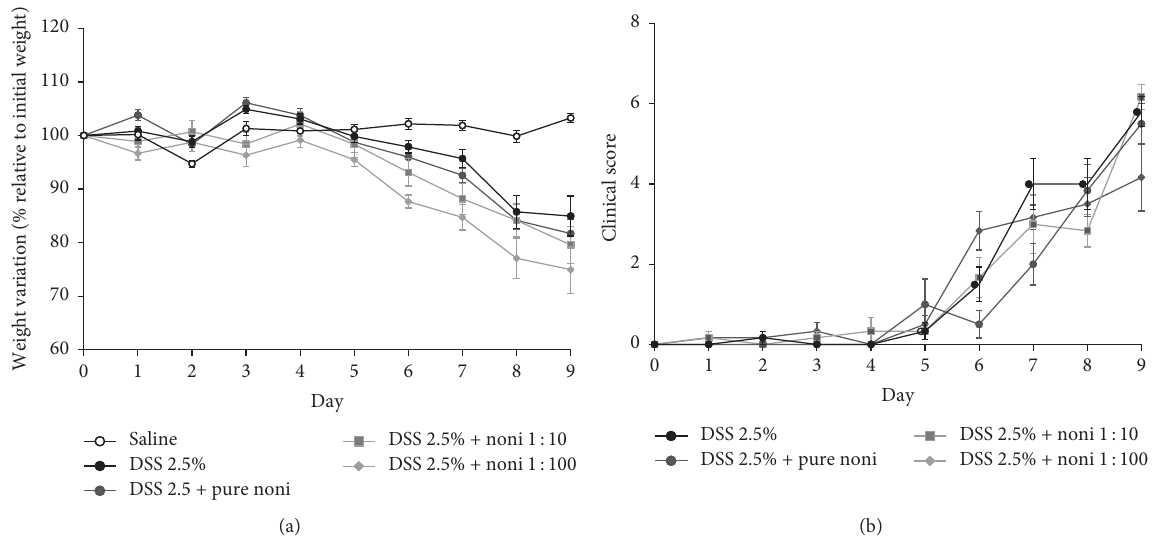
Figure 1: Treatment with noni fruit juice and disease outcome. C57BL/6 mice were exposed to dextran sulfate sodium (DSS) 2.5% and treated daily with noni fruit juice. On day 9, mice were euthanized to obtain intestinal sections. (a) Percentage of weight change. (b) Clinical disease score. Saline , healthy control mice treated with saline; DSS 2.5%, mice exposed to DSS; DSS 2.5% + pure noni , mice exposed to DSS and treated with the pure noni fruit juice; DSS 2.5% + noni 1: 10, mice exposed to DSS and treated with a 1: 10 dilution of the fruit juice; and DSS 2.5% + noni 1:100, mice exposed to DSS and treated with a 1:100 dilution of the fruit